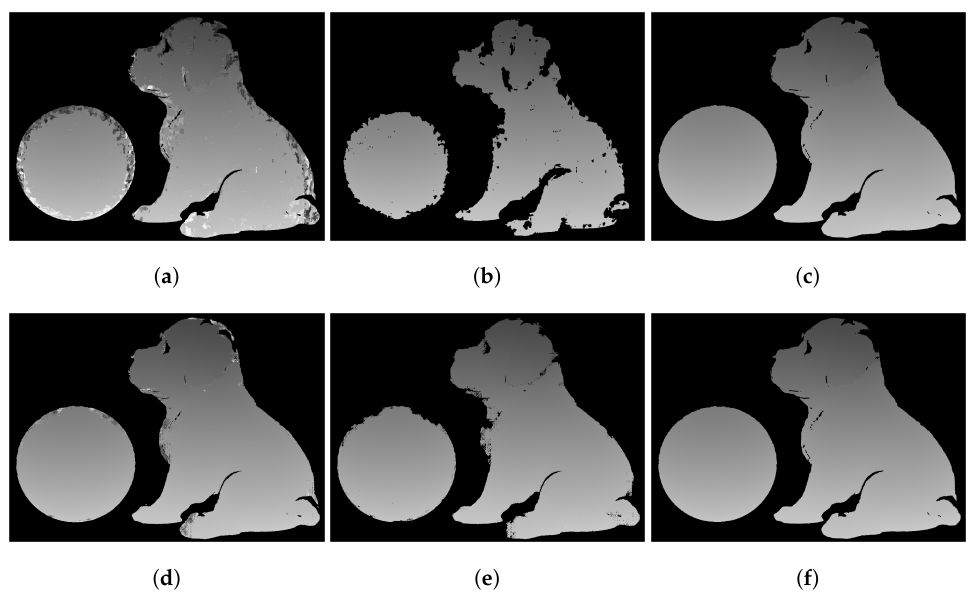
Figure 7. Phase unwrapping process of the 3D objects. ( a ) Low-accuracy absolute phase generated from the DIC-assisted method. ( b ) Partially unwrapped phase map using ( a ) after removing error points. ( c ) Final high-accuracy absolute phase map from the DIC-assisted method. ( d ) Low-accuracy absolute phase map, ˜ Φ , generated from the proposed method. ( e ) Partially unwrapped phase map, Φ 2 , using ( b ) after removing error points. ( f ) Final high-accuracy absolute phase map, proposed method.